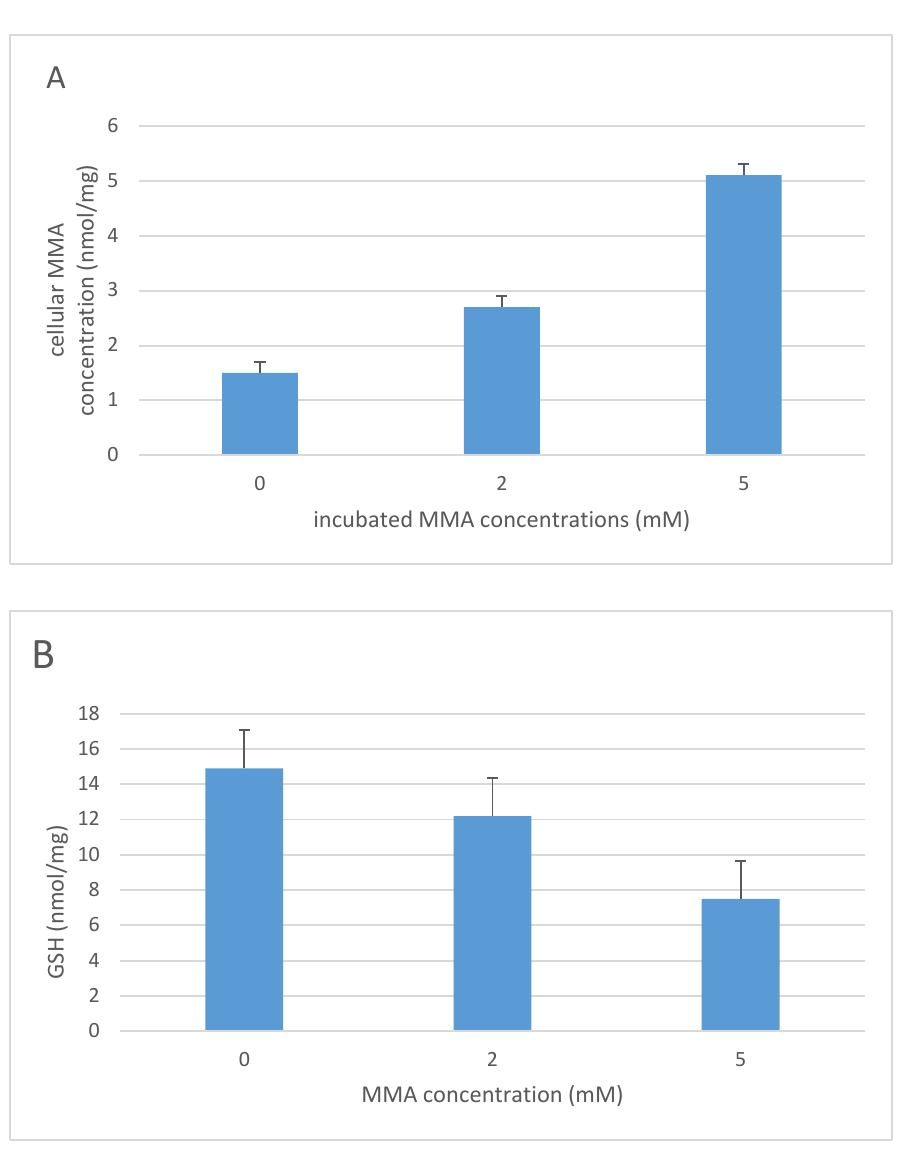
Figure 3. The concentration of cellular MMA ( A ) and GSH ( B ) in human neuroblastoma SHS-5Y cells following 10 days of incubation with MMA (0, 2 and 5 mM). Results are expressed as the mean and standard deviation of five determinations. MMA: Methylmalonic acid; GSH: Reduced glutathione. Previously unpublished data obtained by the authors of this paper with permission given for its publication.